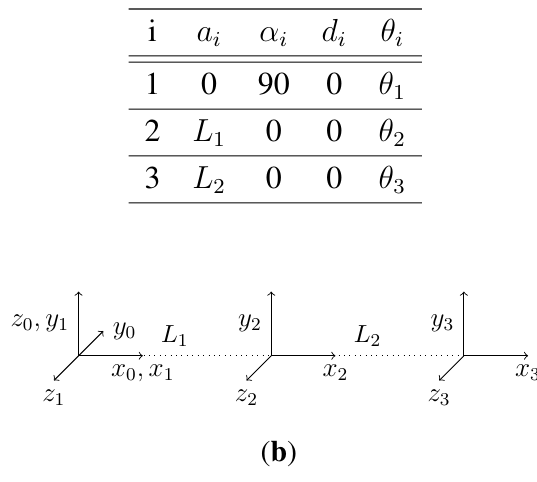
Figure 5. Slave haptic design and the parameter table used for the kinematic modelling according to the D–H convention. ( a ) CAD model of the slave fingers; ( b ) D–H parameter